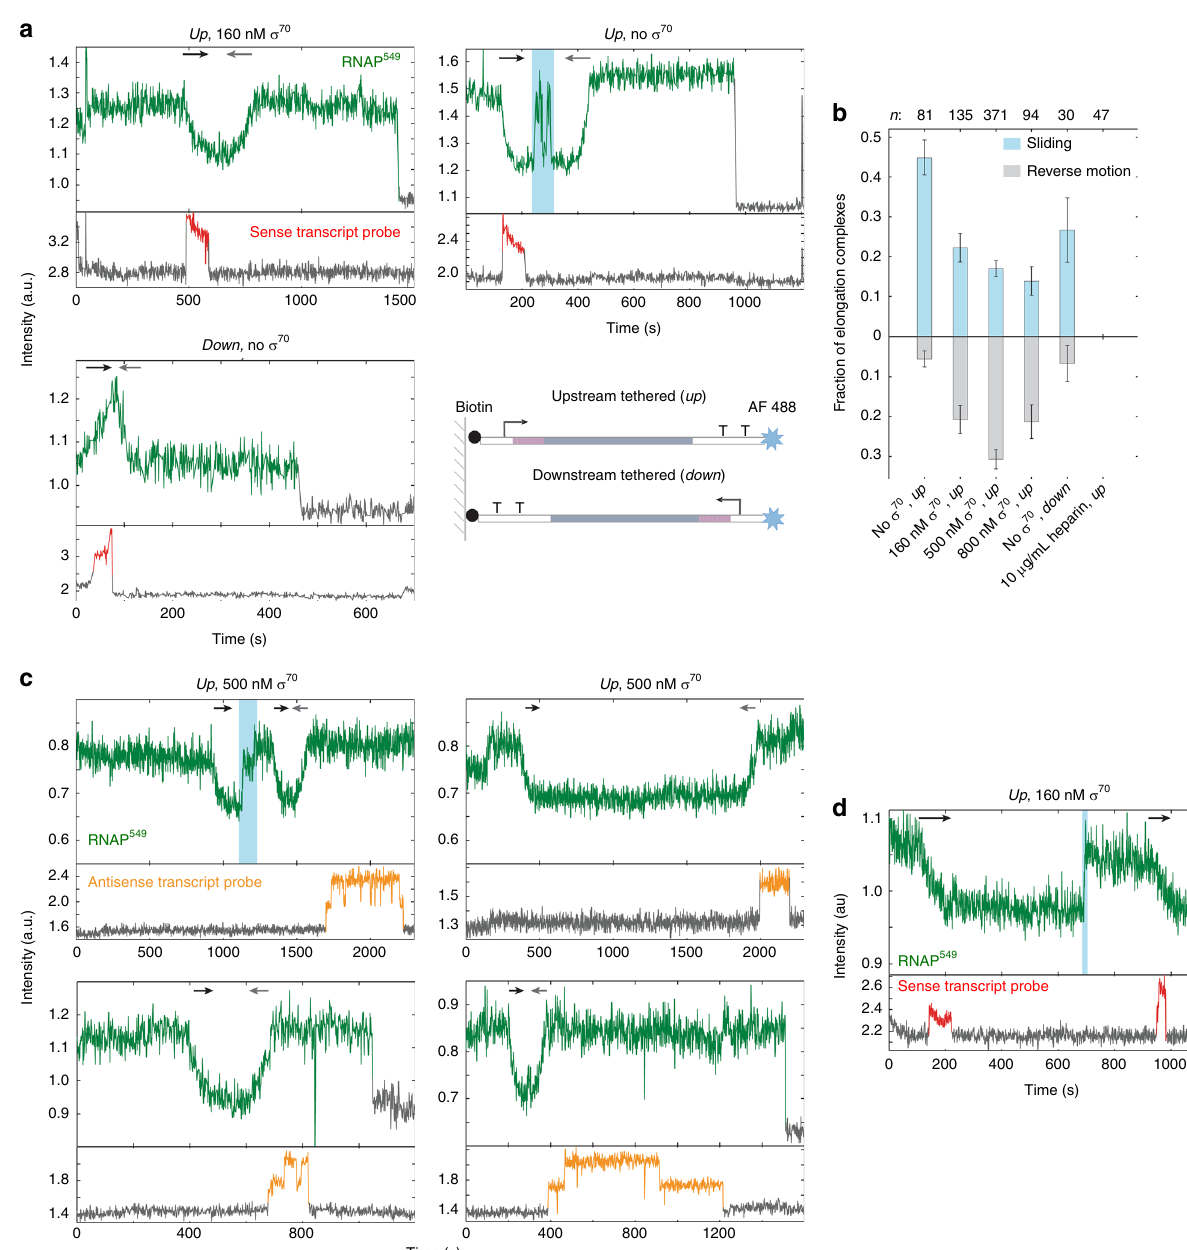
Fig. 3 The post-termination RNAP-DNA complex can re-initiate transcription in the antisense direction. a Single-molecule emission records, as in Figs. 1c, 2a, for three different DNA spot locations from three separate experiments: one with free σ 70 in solution and up template (upper left), one with no free σ 70 in solution and up template DNA (upper right), and one with no free σ 70 in solution and down template DNA (lower left). Black and gray arrows designate episodes of forward and reverse unidirectional motion corresponding to the directions of sense and antisense transcription, respectively. Teal indicates an interval of RNAP 549 random sliding. Lower right: Schematics of up and down templates using the same color scheme as Fig. 1a. b Fraction (±s.e. m.) of RNAP 549 molecules retained at termination (black plus blue populations in Fig. 1d) that slide (teal) or exhibit reverse motion (gray) following termination under different experimental conditions with up or down templates. c Single-molecule emission records as in ( a ) with up template DNA and 500 nM free σ 70 in solution and containing a transcript probe that is the reverse complement of that used in ( a ). d Single-molecule emission record as in ( a ) showing post-termination sliding (teal) followed by secondary initiation in the sense